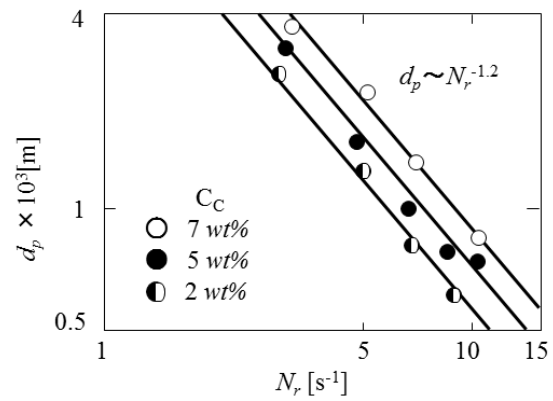
Figure 5. Dependence of mean diameter on impeller speed.